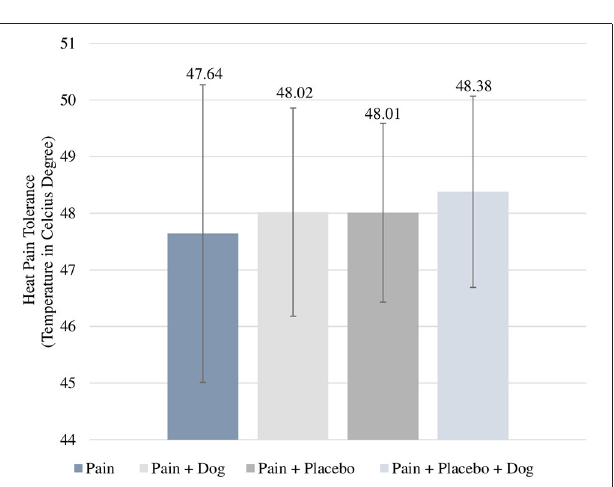
Baseline heat-pain tolerance was associated with p < 0.001 in both